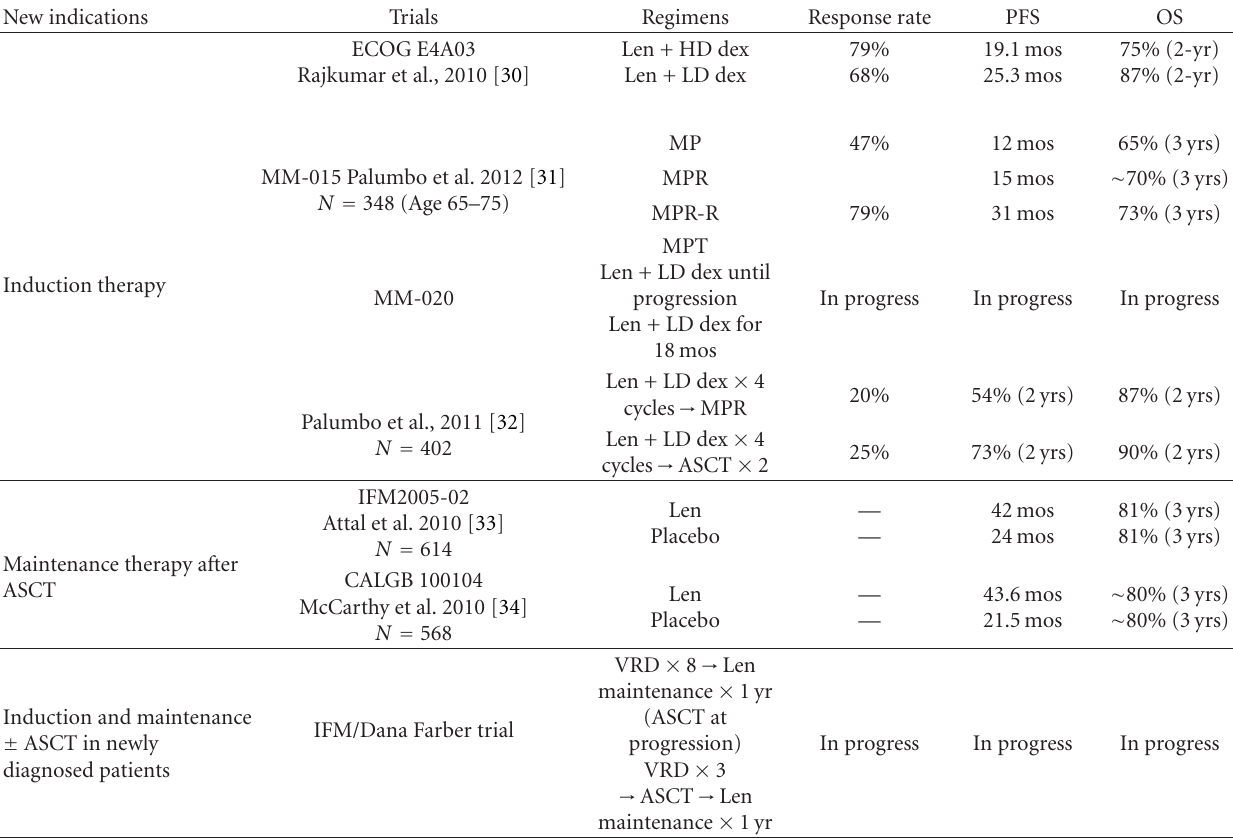
Table 9: Summary of phase III trials evaluating new indications for lenalidomide in the treatment of multiple myeloma. New indications